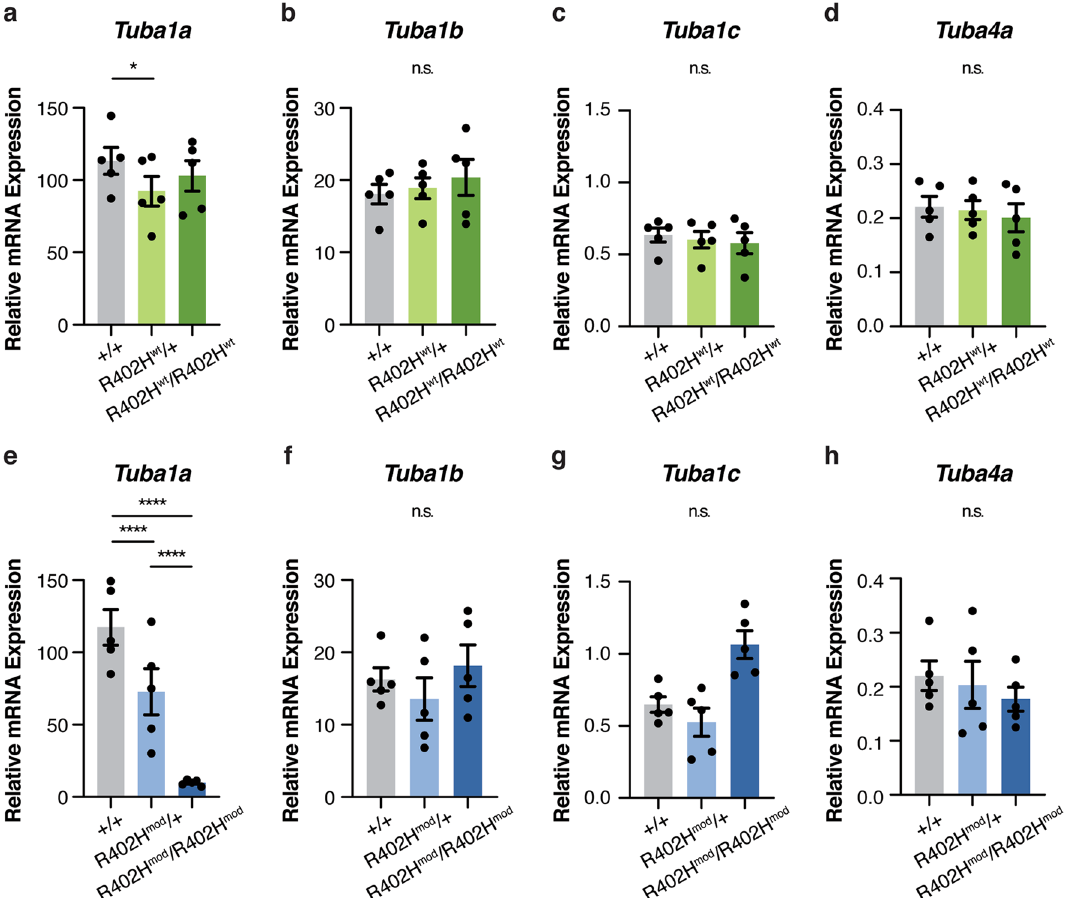
Figure 5. Expression levels of mouse α-tubulin genes in the developing brain are perturbed in the R402H Tuba1a (modified) line. ( a–d ) mRNA expression levels of Tuba1a ( a ) , Tuba1b ( b ) , Tuba1c ( c ) and Tuba4a ( d ) were assessed by qPCR in E16.5 wild-type (grey), heterozygous (light green), and homozygous R402H wt / R402H wt (dark green) embryos. We found a slight reduction in the expression levels of Tuba1a levels between wild-type and heterozygous animals (n = 5, + / + vs. R402H wt / + P < 0.05). ( e–h ) mRNA expression levels of Tuba1a ( e ) , Tuba1b ( f ) , Tuba1c ( g ) and Tuba4a ( h ) were assessed by qPCR in E16.5 wild-type (grey), heterozygous (light blue), and homozygous R402H mod /R402H mod (dark blue) embryos. There was a significant reduction in Tuba1a levels in both heterozygous and homozygous animals (n = 5, + / + vs. R402H mod / + P < 0.0001; + / + vs. R402H mod / R402H mod P < 0.0001 and R402H mod / + vs. R402H mod /R402H mod P < 0.0001). Error bars show mean ± s.e.m.. Two- way repeated measures ANOVA with Tukey’s test for multiple comparisons; n.s.—not significant; * P < 0.05; **** P <